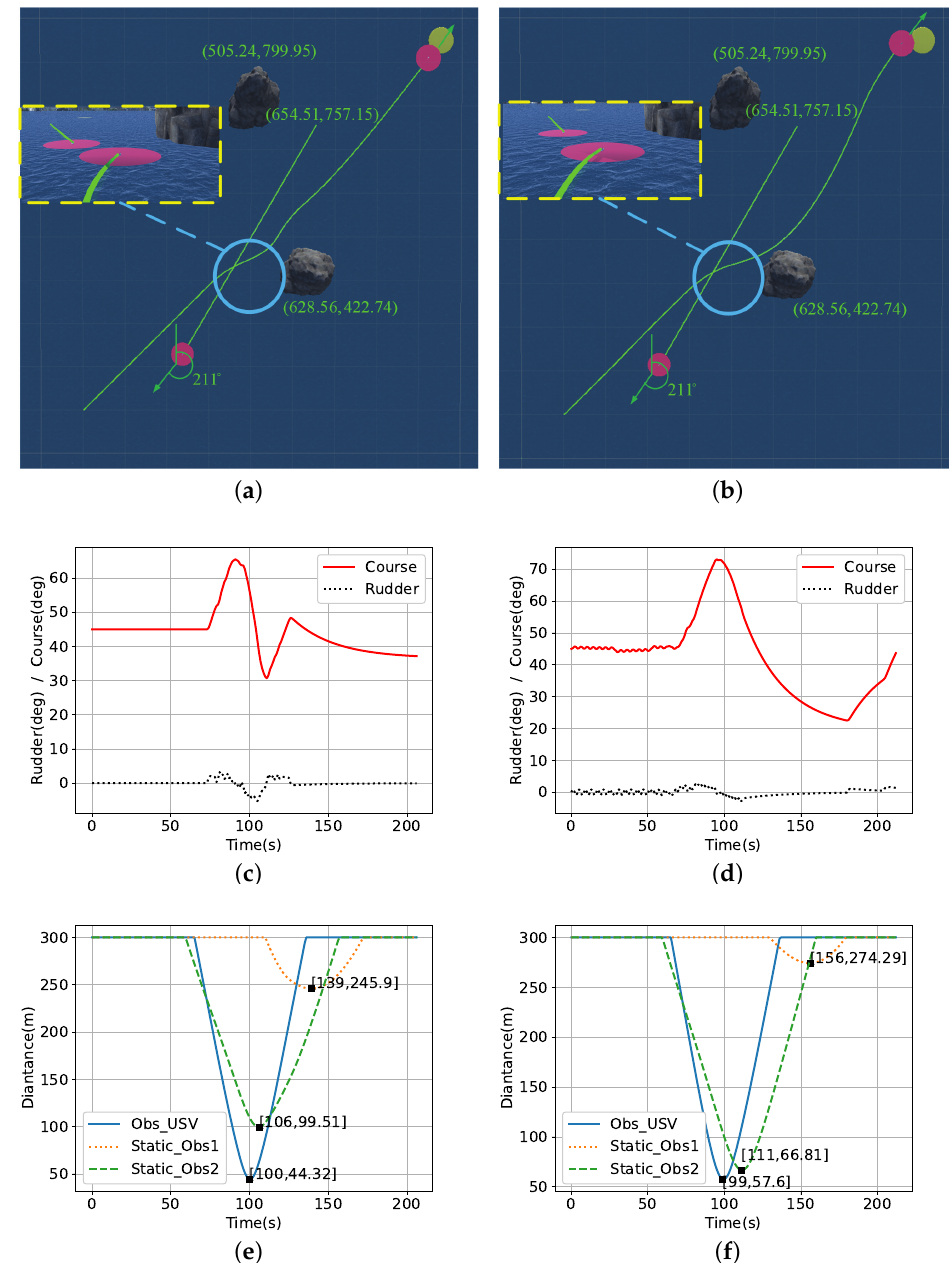
Figure 12. Encounter situation 2. ( a ) Path planned by DRLCA; ( b ) Path planned by DQN; ( c ) Course and rudder for DRLCA; ( d ) Course and rudder for DQN; ( e ) Distance for DRLCA; ( f ) Distance for DQN. The third test environment is shown in Figure 13. The interference from the obstacle USV is not significant, which can verify the ability to avoid static obstacles. Figure 13a,b show the effect of collision avoidance of DRLCA and DQN. The initial position of the USV O , static obstacles 1 and 2 are ( 789.77, 422.35 ) , ( 538.82, 644.89 ) , and ( 461.18, 355.11 ) . The course of obstacle USV is 285. Figure 13c,d shows the change of rudder angle and course of collision avoidance of DRLCA and DQN. Figure 13e,f shows the distance in collision avoidance of DRLCA and DQN. The accumulated course deviation is 3371.51 ◦ for DRLCA, and DQN could not compare because of the incomplete navigation. The closest distances to the three obstacles are 136.02 m, 100.57 m, and 138.48 m for DRLCA and 36.45 m, 65.79 m, and 103.96 m for